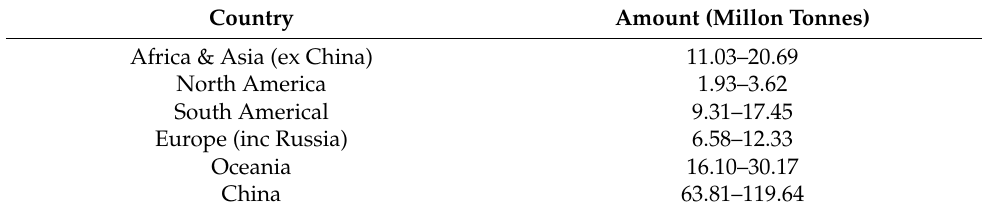
Table 1. Annual production of RM in different countries for 2022